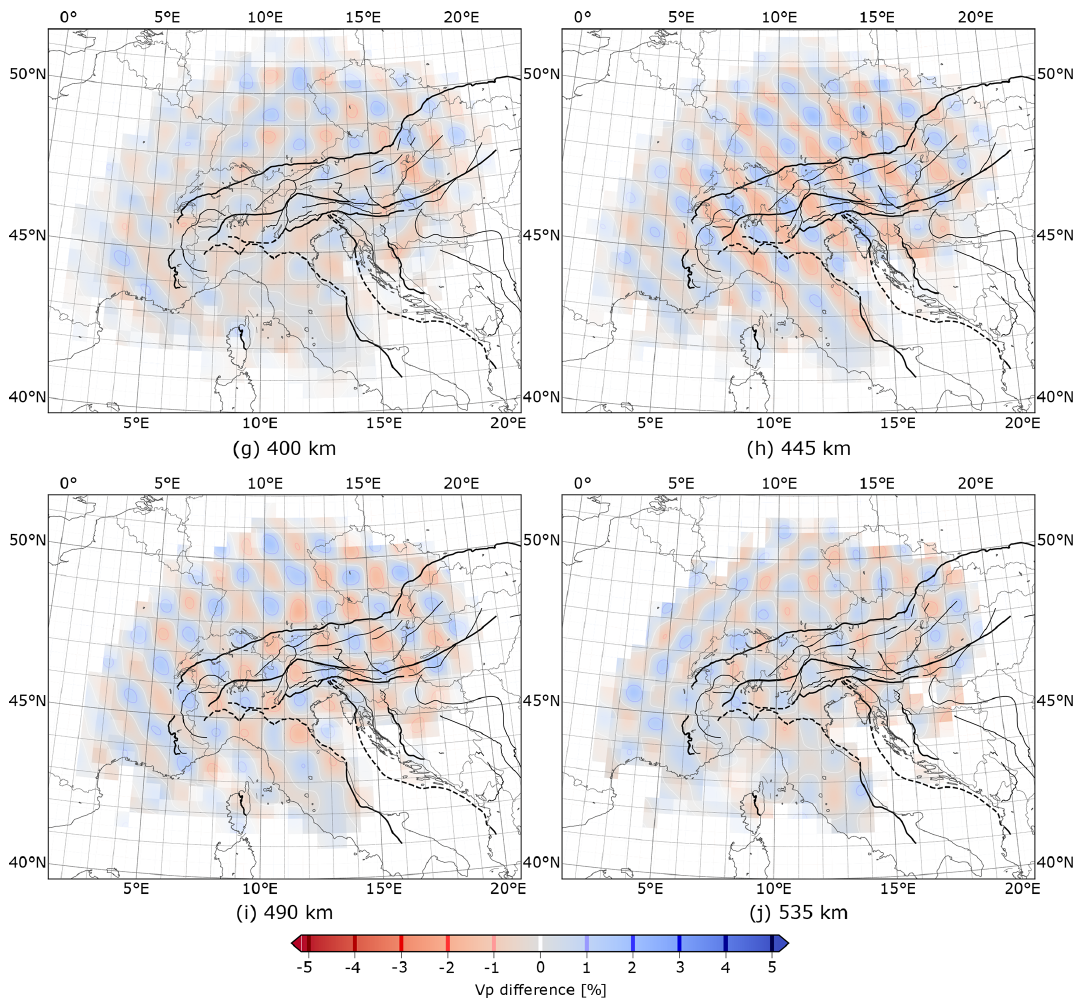
Fig. 11, we choose the values of 10 for the damping and 30 for the smoothing